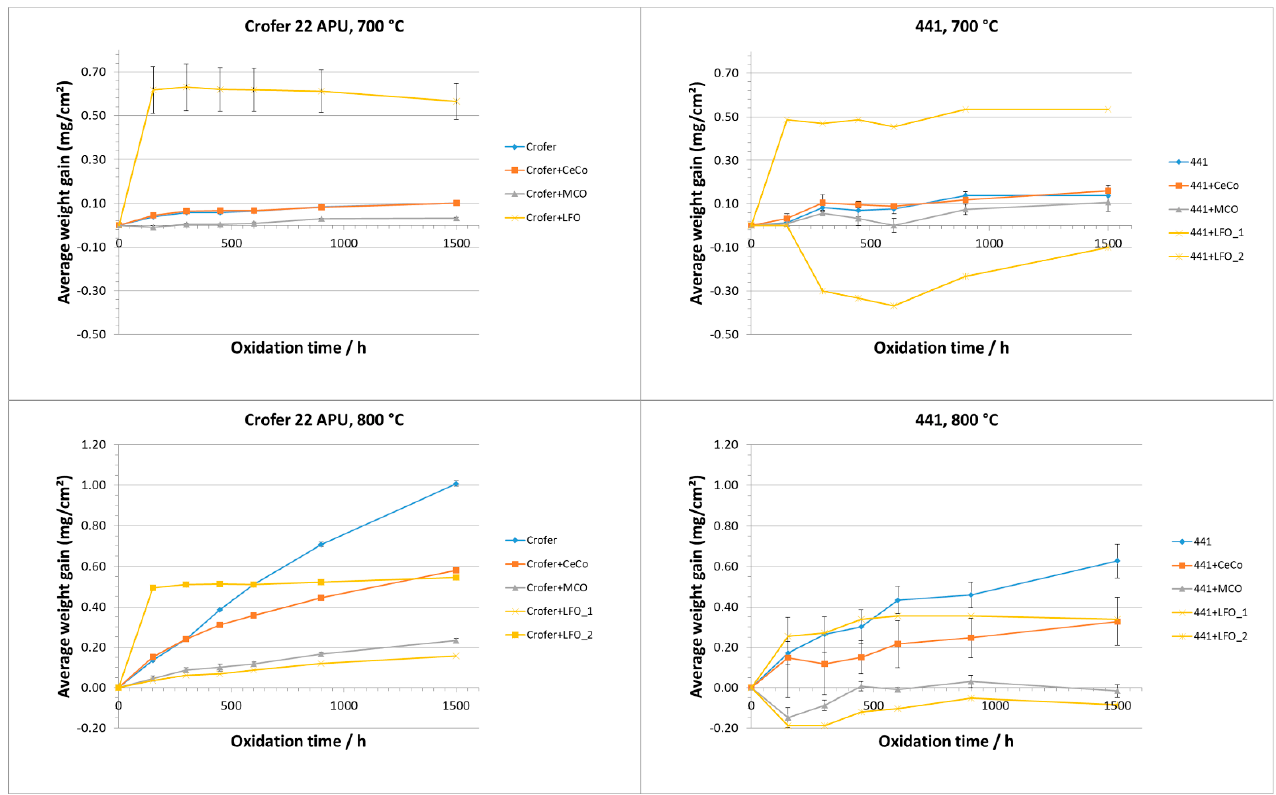
Figure 1. Average weight gain of the samples in oxidizing atmosphere at 700 °C ( upper row ) and 800 °C ( lower row ) with standard deviations. For the Ce/Co coated samples, 0.19 mg/cm 2 is subtracted from the initial weight gain to account for oxidation of Co.